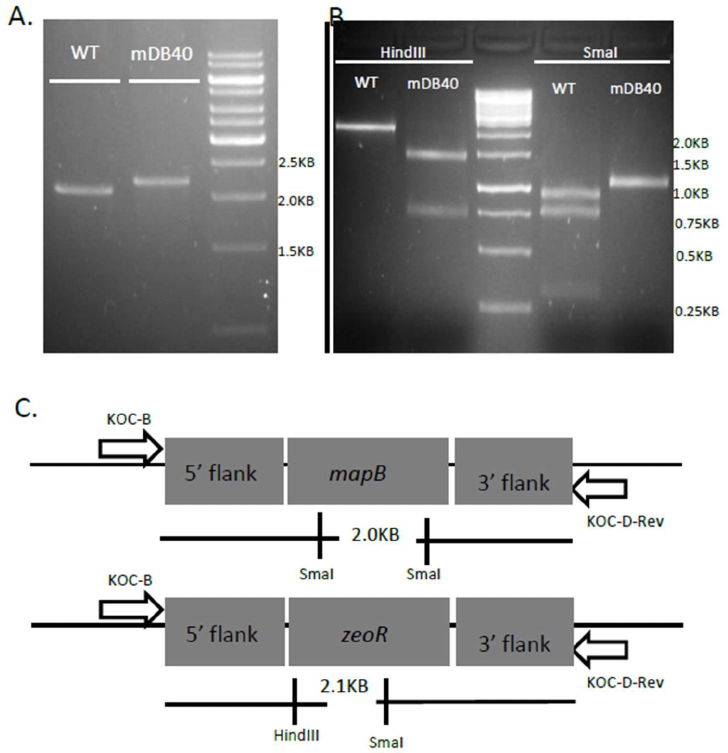
Figure 3. Deletion of the native mapB . ( A ) A zeocin resistant colony (mDB40) was analyzed by PCR. In wt, the product size is 2KB, whereas in a correct deletion mutant it is 2.1KB. ( B ) The digestion pattern produced by wt or mDB40 when digested by HindIII (no effect on wt, 1.3, 0.7KB in deletion) or SmaI (0.9, 0.7, 0.3KB in wt, 1.05, 1.05 in deletion mutant) confirms the correct allelic exchange in mDB40 (see diagram in ( C )).